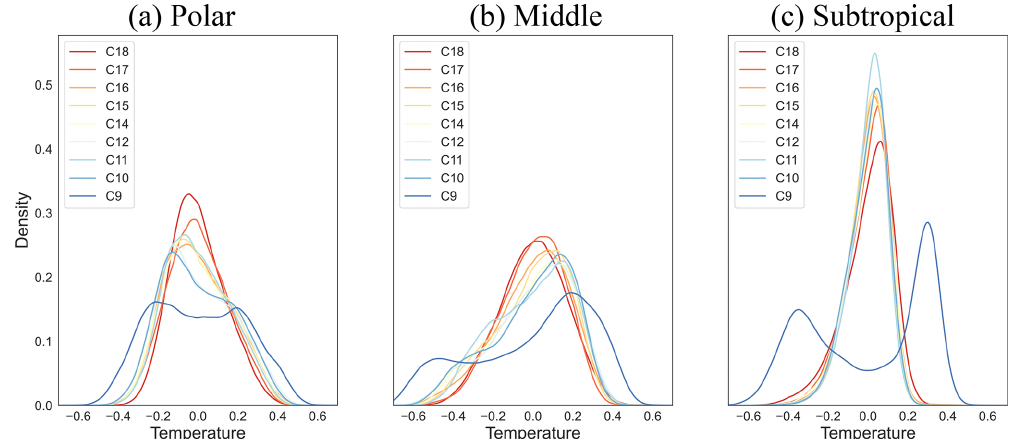
Figure 7. PDFs of temperature anomalies for the nine experimental runs at different (cid:49)T values calculated at fixed latitudes p (a) , m (b) , and e (c) ; see Fig. 6 for the regions in the annulus.